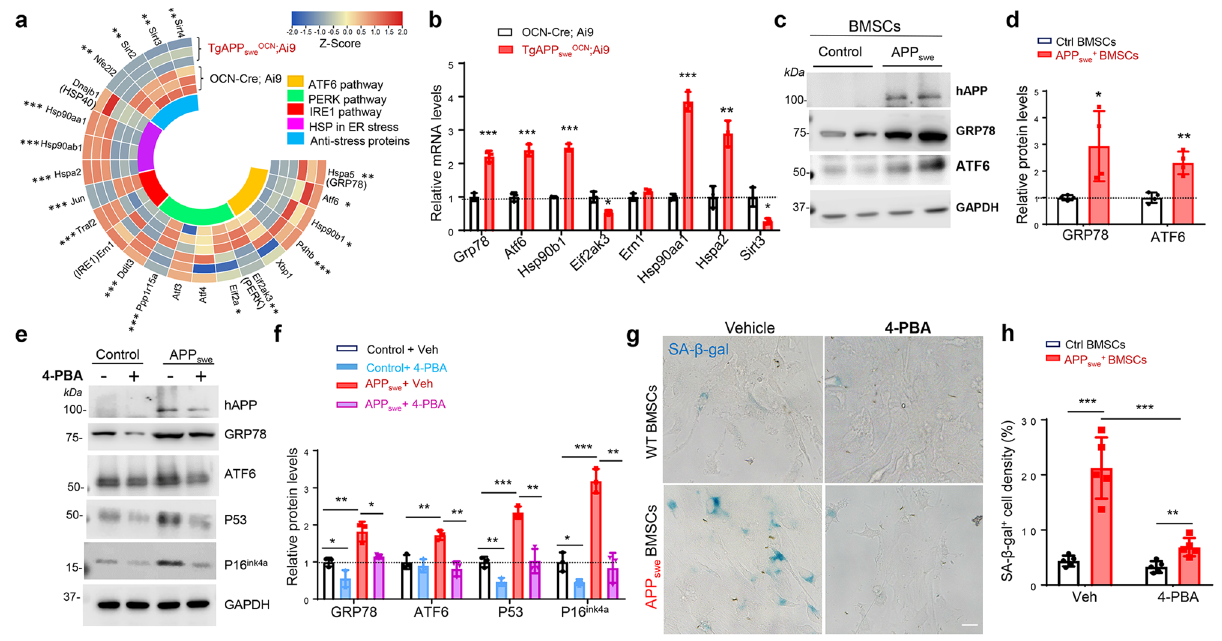
Fig. 9 APP swe induction of OB-senescence via ER stress. a Heat map of differentially expressed ER stress or anti-stress related genes identi fi ed by RNA- seq in control ( OCN-Cre; Ai9 ) and TgAPP swe OCN ; Ai9 Td + OB-progenitors (detail analysis was described in Methods). b RT-PCR analysis of ER stress-related genes Grp78, Atf6, Hsp90b1 , Eif2ak3, Ern1, Hsp90aa1 , and Hspa2 and anti-stress related gene Sirt3 gene expression in puri fi ed Td + BMSCs from 6-MO control ( OCN-Cre; Ai9 ) and TgAPP swe OCN ; Ai9 mice, * p < 0.05, ** p < 0.01, *** p < 0.001, mean ± SD, n = 3, Mann – Whitney U test. c Western blot analysis of indicated protein expression in BMSCs from mice with indicated genotypes (at 6-MO). GAPDH was used as a loading control. d Quanti fi cation of data in c , * p < 0.05, ** p < 0.01. mean ± SD, n = 4, Student ’ s t test. e Western blot analysis of indicated protein expression in BMSCs from 6-MO control and TgAPP swe OCN with or without 0.25 mM 4-PBA (4-Phenylbutyric acid) treatment. f Quanti fi cation analyses of the data in e , * p < 0.05, n = 3. g SA- β -gal staining of 6-MO control and TgAPP swe OCN BMSCs with vehicle (Veh)(PBS) and 4-PBA treatment, respectively, scale bar, 20 µ m. h Quanti fi cation of SA- β - gal + cell densities in g (mean ± SD; n = 5, ** p < 0.01, *** p < 0.001). Two-way analysis of variance test was used in f and h